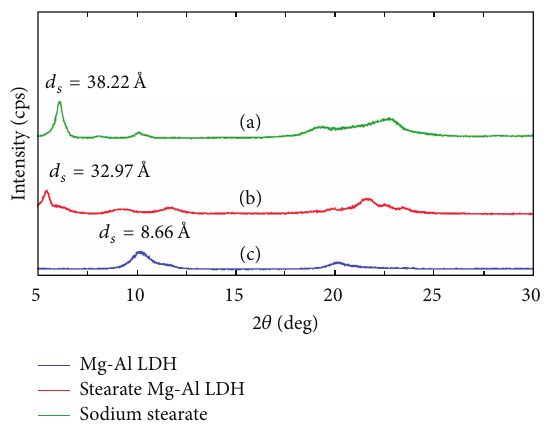
Figure 2: XRD patterns of (a) pristine Mg-Al LDH, (b) stearate Mg- Al LDH, and (c) sodium stearate.